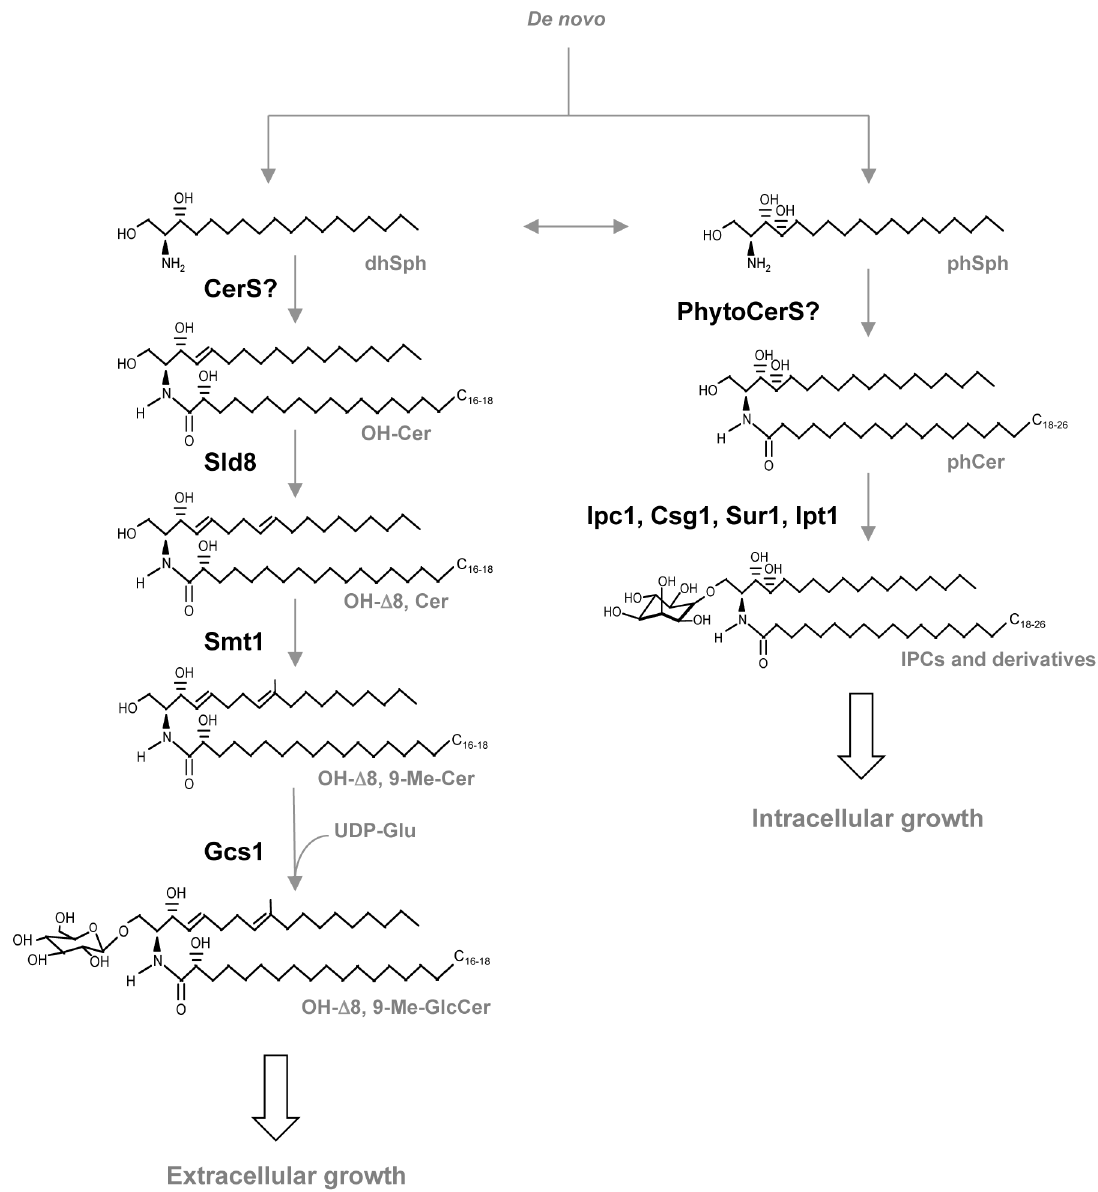
Figure 2. Glycosphingolipid pathway in fungi. dhSph, dihydrosphingosine; CerS, ceramide synthases; OH-Cer, a -hydroxy-ceramide; Sld8, D 8 desaturase; OH- D 8-Cer, a -hydroxy- D 8-ceramide; Smt1, C9-methyl transferase; OH- D 8, 9-Me-Cer, a -hydroxy- D 8, 9-methylceramide; Gcs1, glucosylceramide synthase 1; OH- D 8, 9-Me-GlcCer, a -hydroxy- D 8, 9-methyl-glucosylceramide; phSph, phytosphingosine; PhytoCerS, phytoceramide synthases; phCer, phytoceramide; Ipc1, inositol-phosphoryl ceramide synthase 1; Csg1, mannosyl phosphorylinositol ceramide synthase regulatory protein; Sur1, mannosyl phosphorylinositol ceramide synthase; Ipt1, inositol phosphotransferase 1; IPC, inositol phosphoryl ceramide.